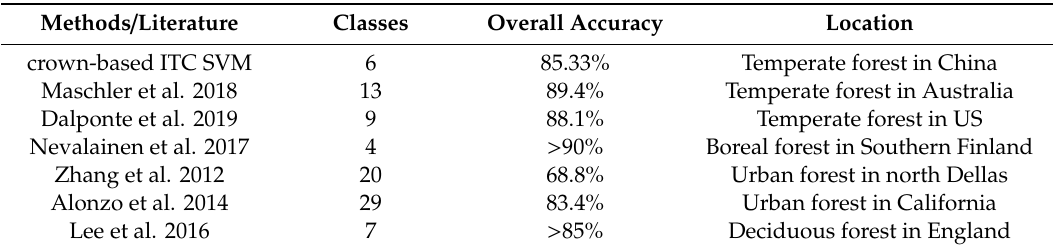
Table 7. The overall accuracy comparison of some individual tree species classification